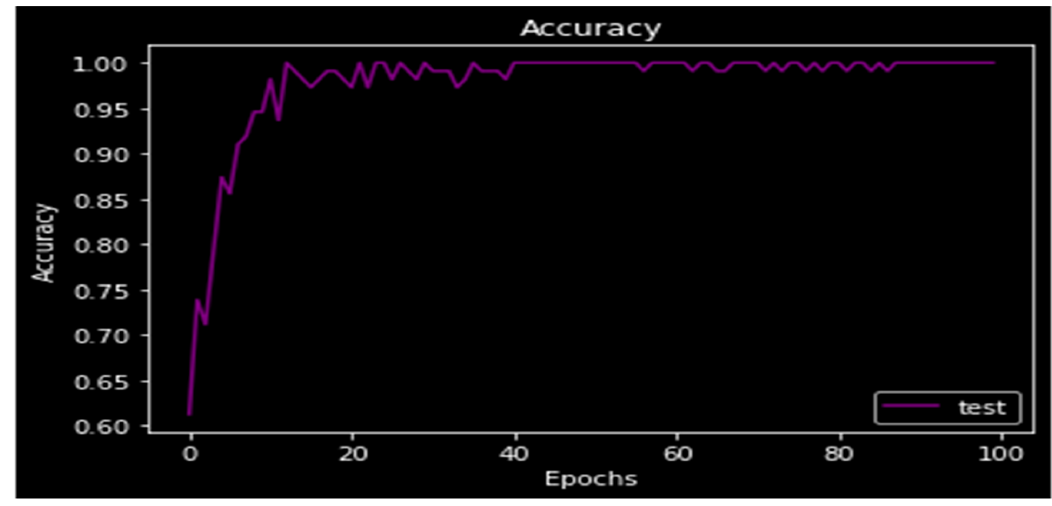
Figure 10. Accuracy. Figure 10.